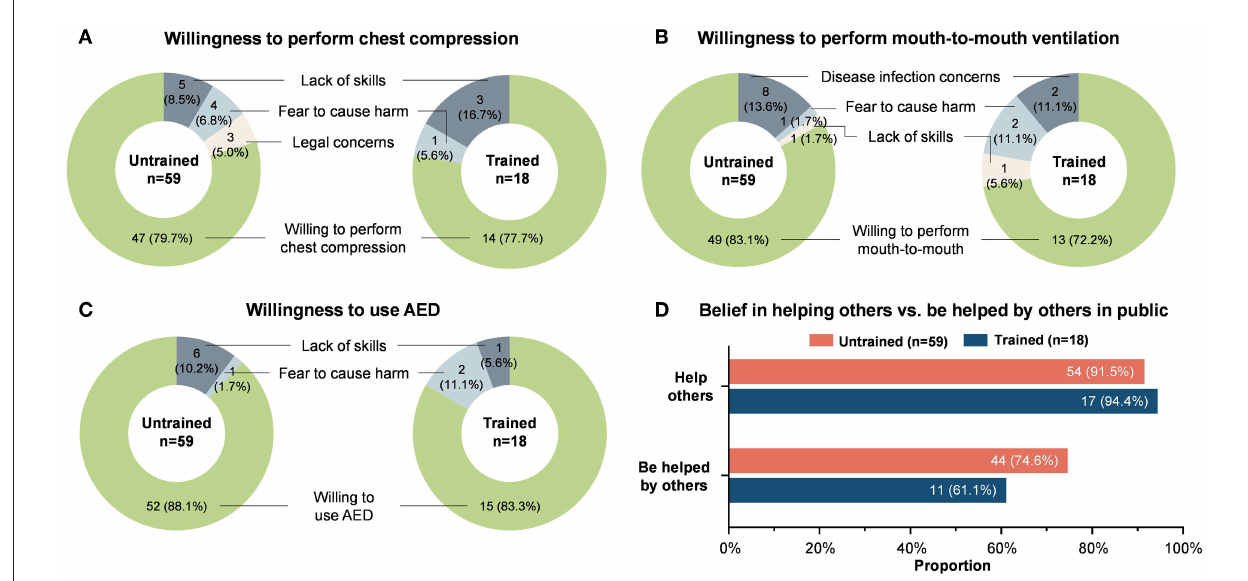
FIGURE4 Respondents’ willingness to perform chest compression (A) , mouth-to-mouth ventilation (B) , and AED (C) on others, and belief in helping others and being helped by others in public (D) . Values are shown as proportions. AED, automated external defibrillator.